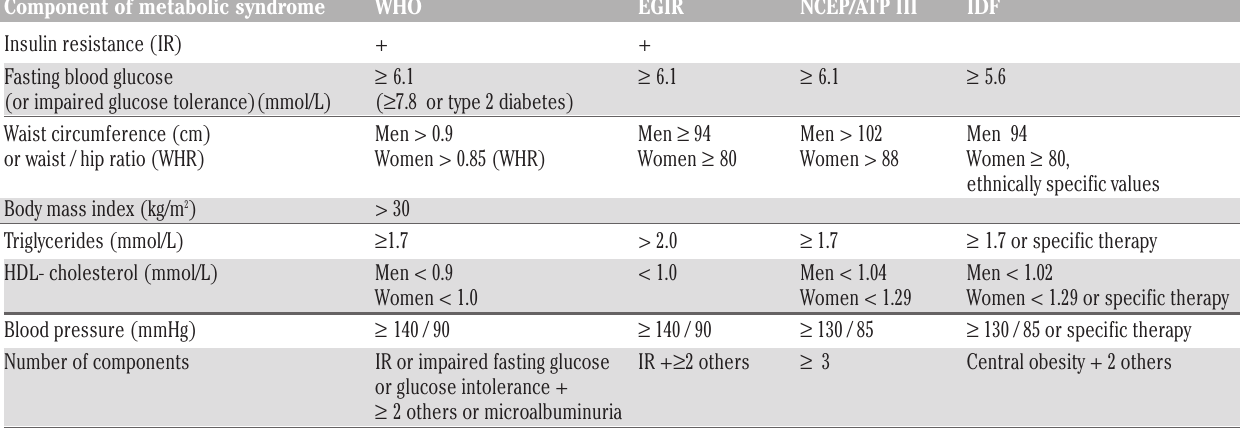
Table 1. Definition of metabolic syndrome according to the World Health Organization (WHO), 2 the National Cholesterol Education Program/Adult Treatment Panel III (NCEP/ATP III), 3 the European Group for the study of Insulin Resistance (EGIR) 23 and the International Diabetes Federation (IDF). 5